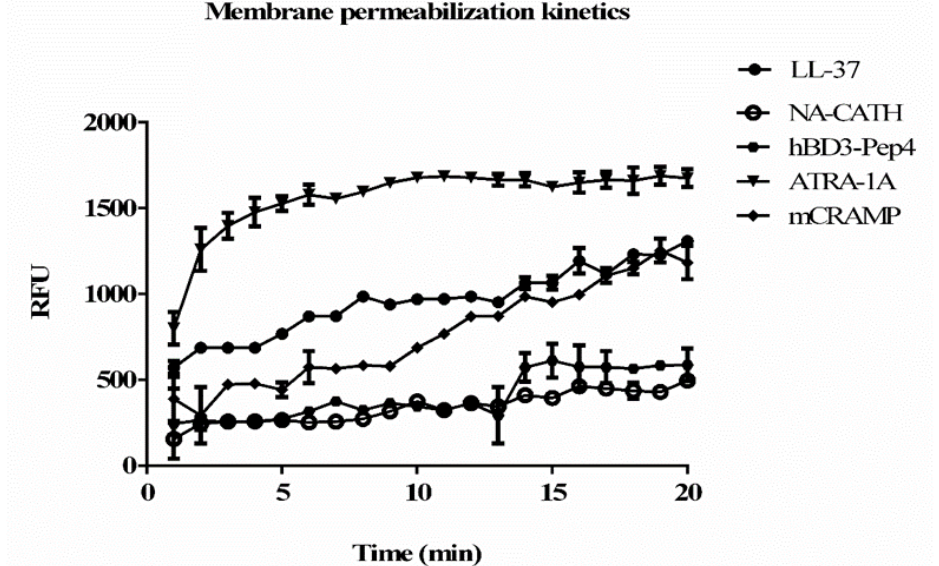
Figure 2. Kinetics of permeabilization and binding of ethidium bromide to DNA with 50 μg/mL of peptide concentration. Pore-forming activity by the peptides tested in the studies: hBD3-Pep4, ATRA-1A, mCRAMP, LL-37, and NA-CATH. An increase